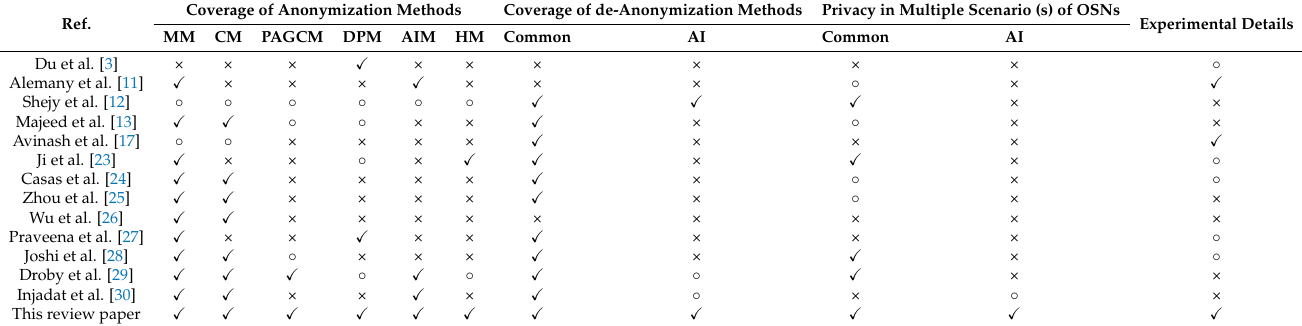
Table 1. Overview and comparisons of existing surveys with our review paper.